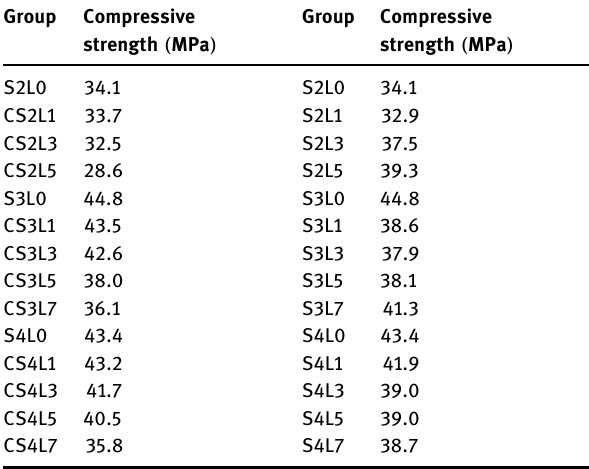
Table 4: 3D compressive strength of cement paste specimens